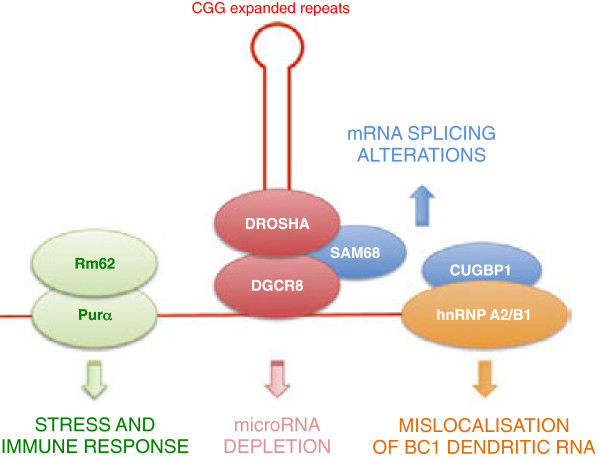
Various RNA binding proteins have been found to associate with RNAs containing expanded CGG repeats. Purα, DGCR8, and hnRNP A2/B1 bind directly to the CGG-containing RNA, whereas Rm62, SAM68, and CUGBP1 are recruited in trans through protein-protein interactions.